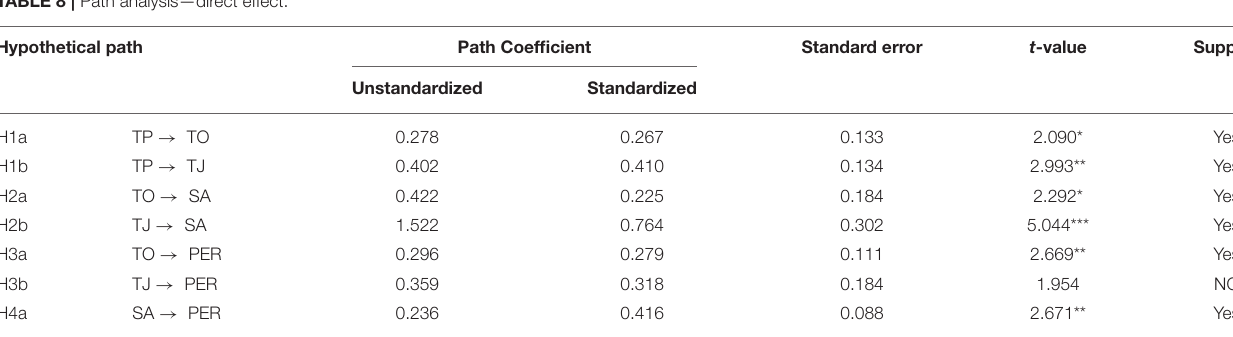
TABLE 8 | Path analysis—direct effect. Hypothetical path